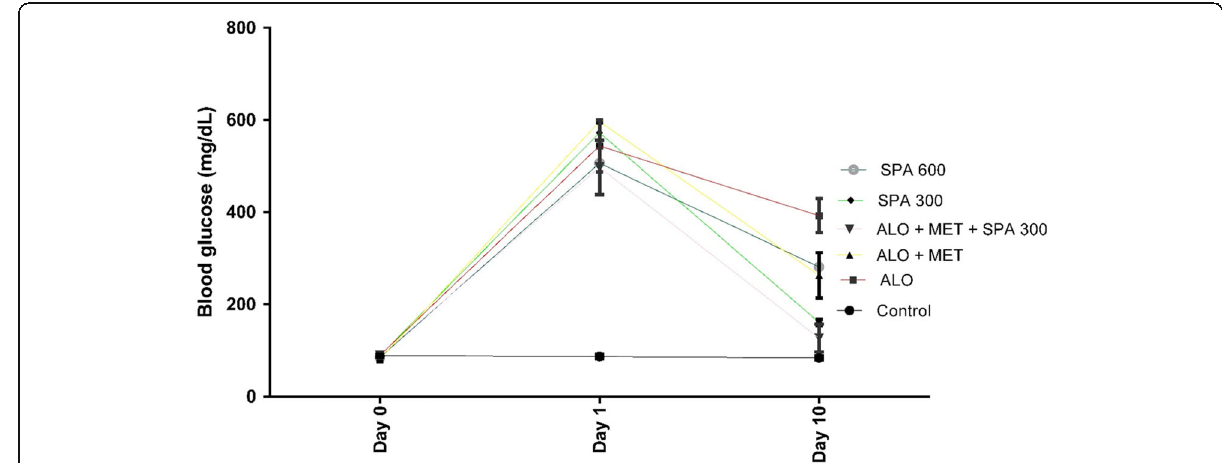
Fig. 2 Effect of methanol extract of S. sparganophora leaves on fasting blood glucose concentration of alloxan-induced hyperglycemic